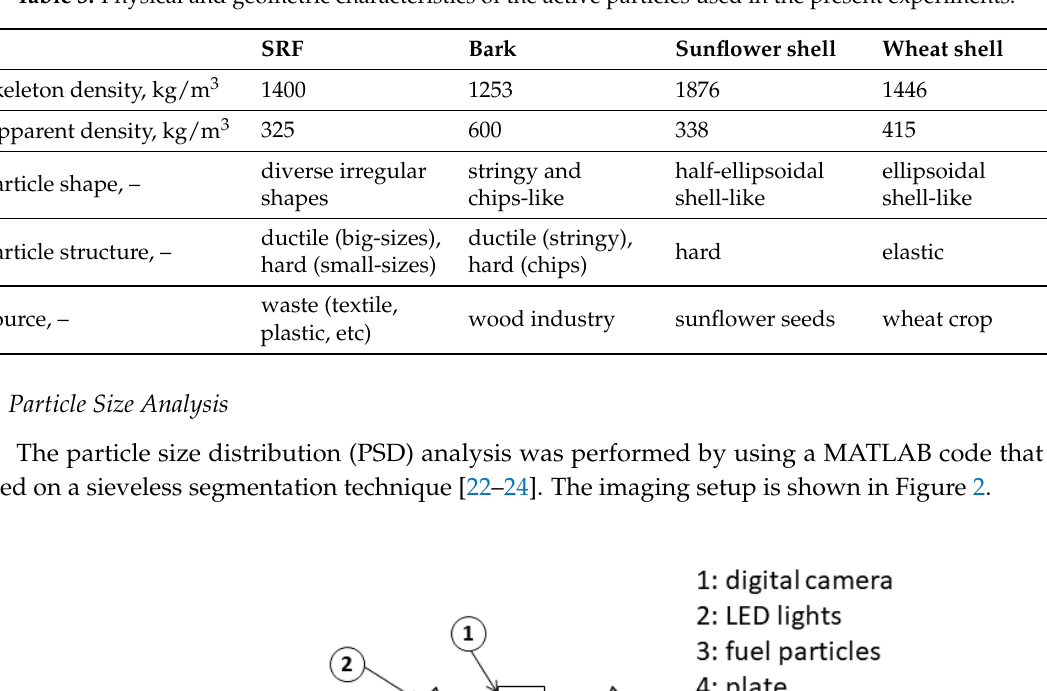
Table 3. Physical and geometric characteristics of the active particles used in the present experiments.